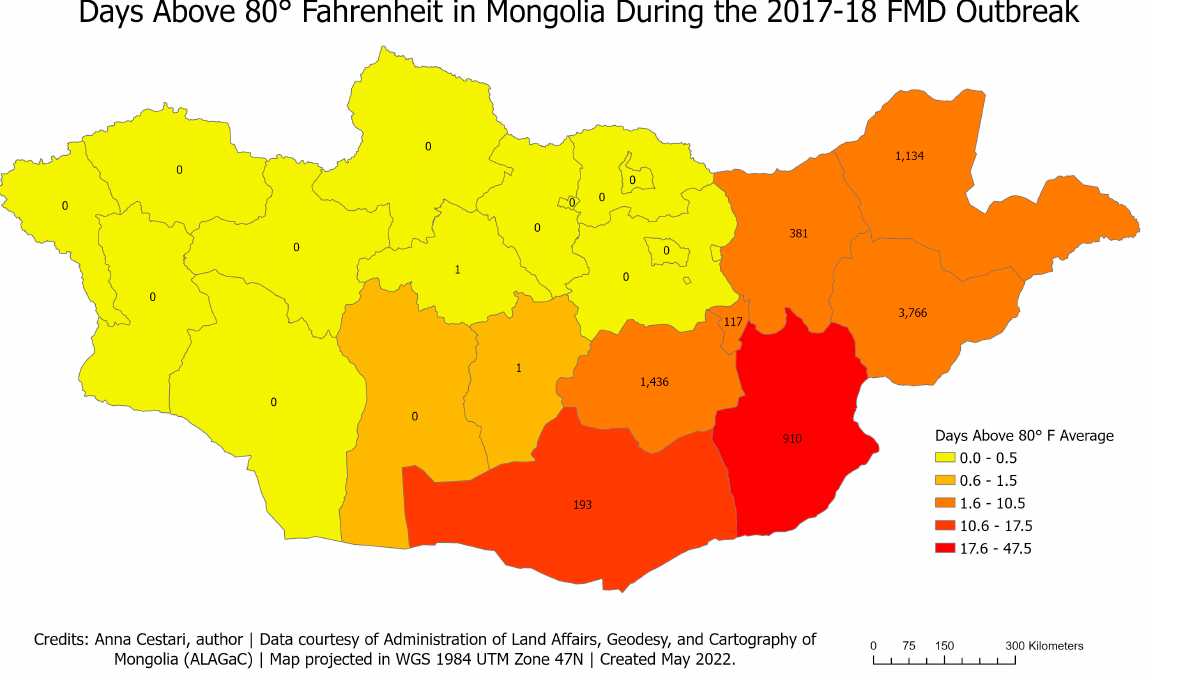
Figure 5. This map shows the provinces in Mongolia with the color shading based on the number of days with temperature above 80 ◦ F. The darker colors represent more days above 80 ◦ F. Each province is labeled with its number of foot and mouth disease cases for the 2017–2018